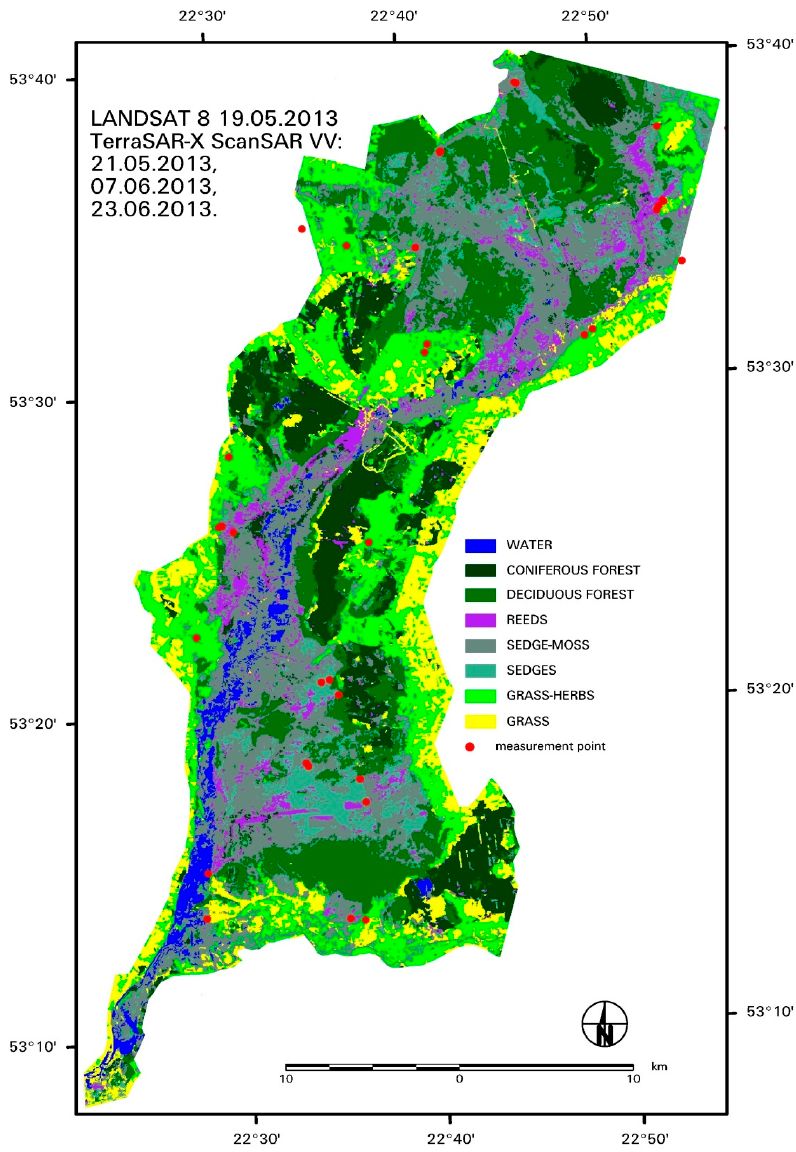
Figure 2. Map of Biebrza Wetland vegetation habitat types.